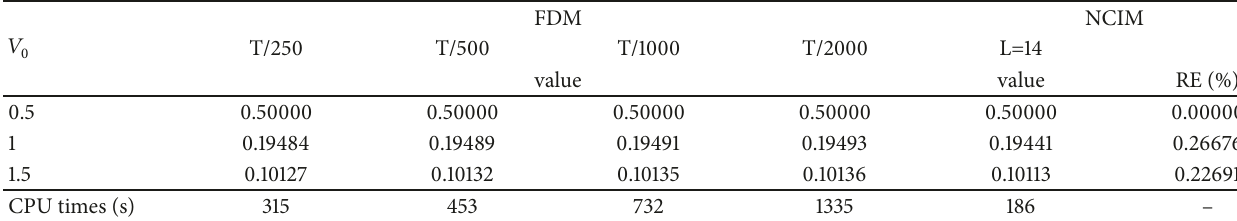
Table 5: Comparison results (option values, relative errors and CPU time).